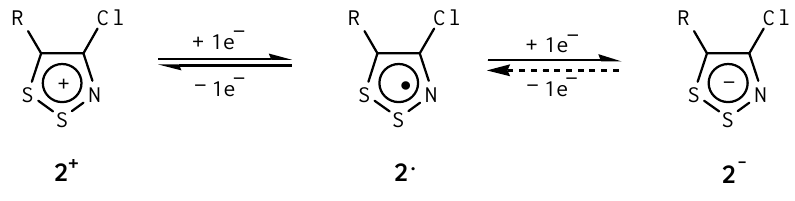
a For acetonitrile solutions at room temperature. b For CD from acetonitrile-diethyl ether by vapour